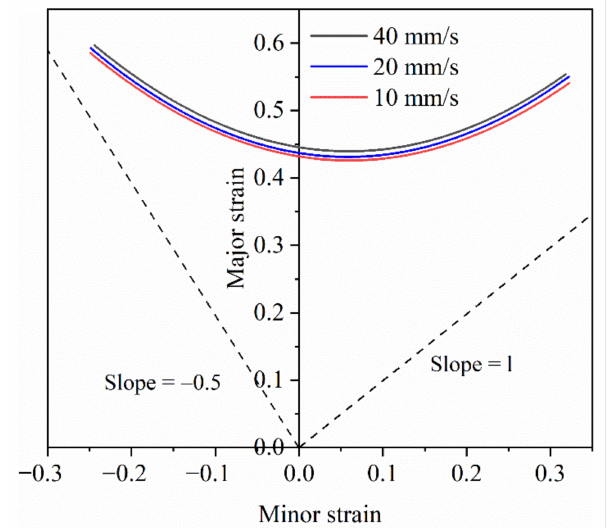
Figure 10. Forming limit curves at different stamping speeds of 410 ◦